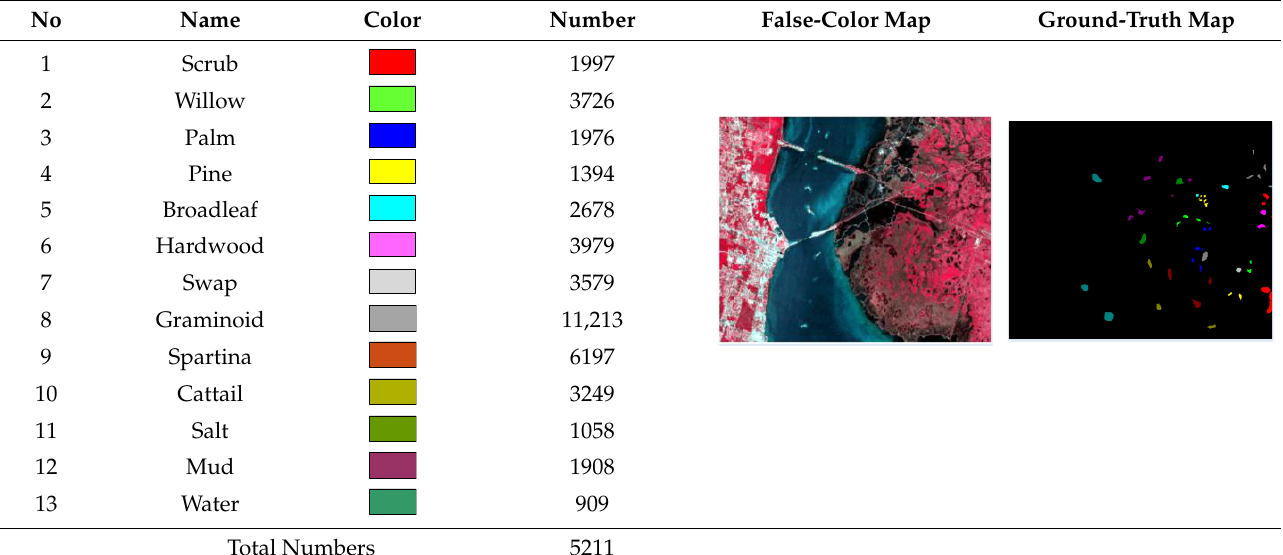
Table 1. Salinas Dataset Labeled Sample Counts.